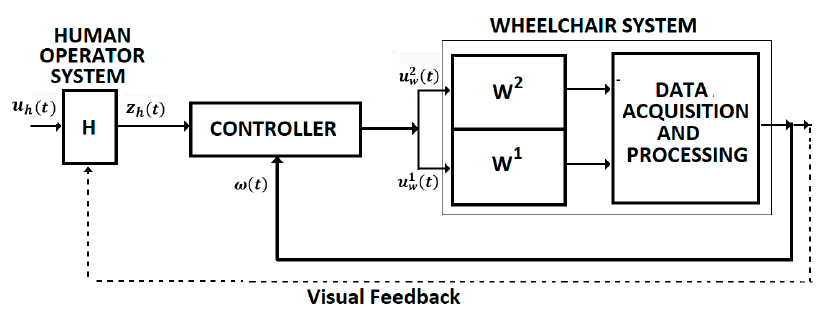
Figure 7. Wheelchair control system.